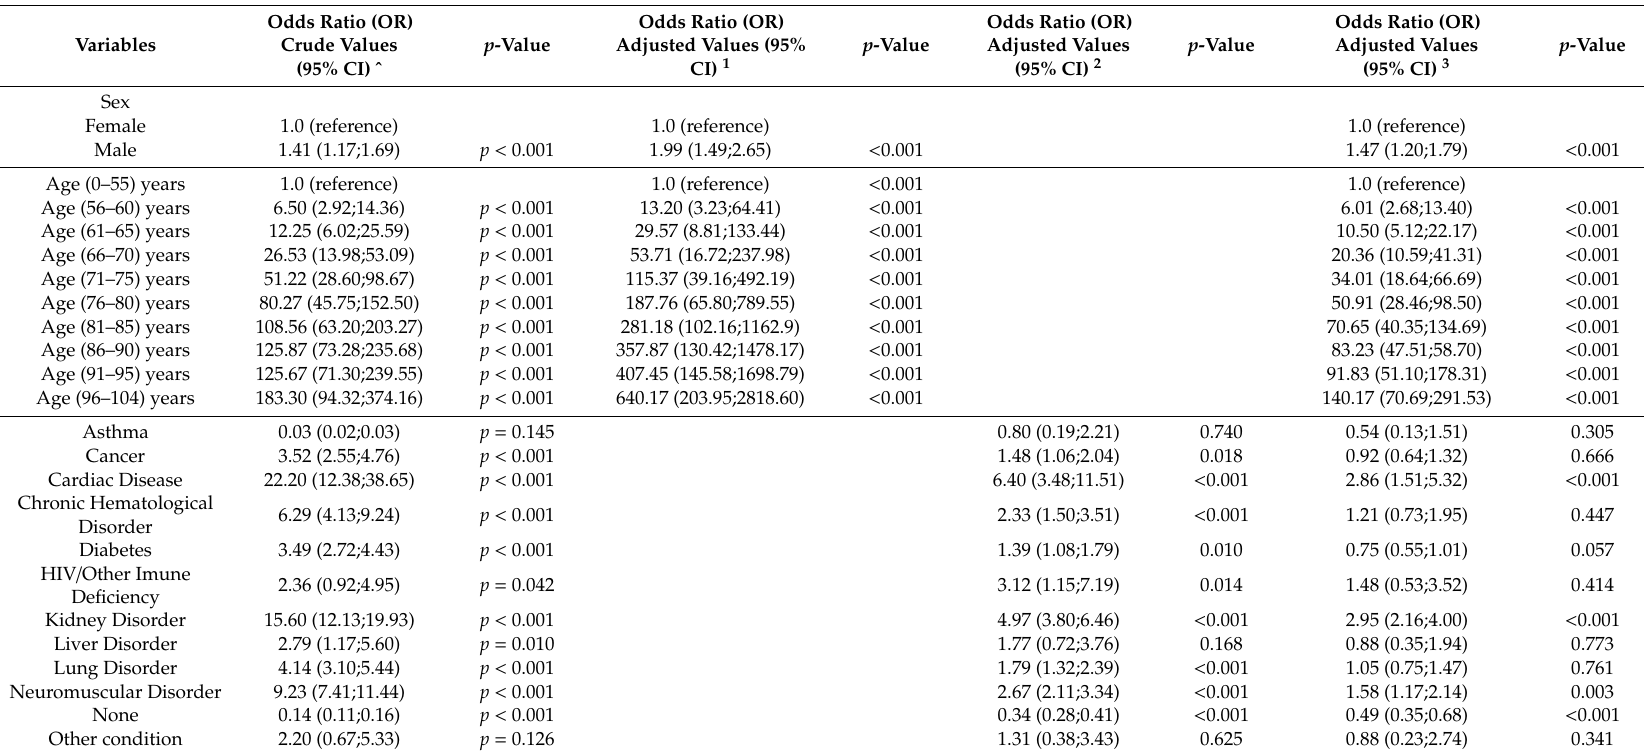
Table 3. Univariable and Multivariable logistic regression analyses for the outcome “death” in infected individuals with